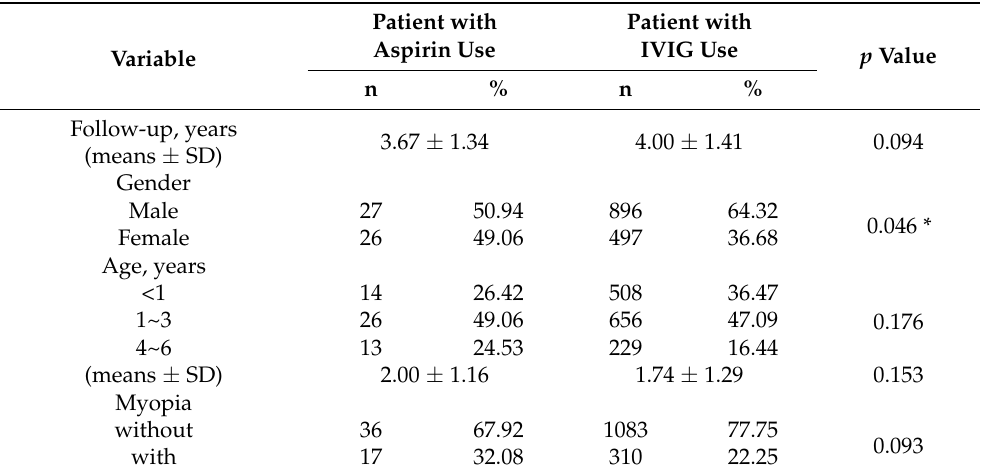
Variable Table 1. Demographic data of Kawasaki disease patients.